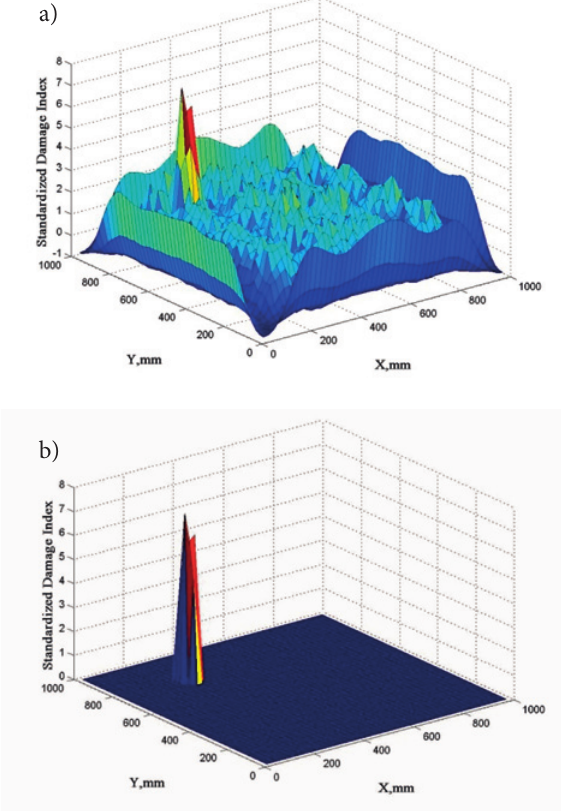
fig. 4. Standardized MSCSM damage index for test case 6.1: (a) before truncation and (b) after truncation